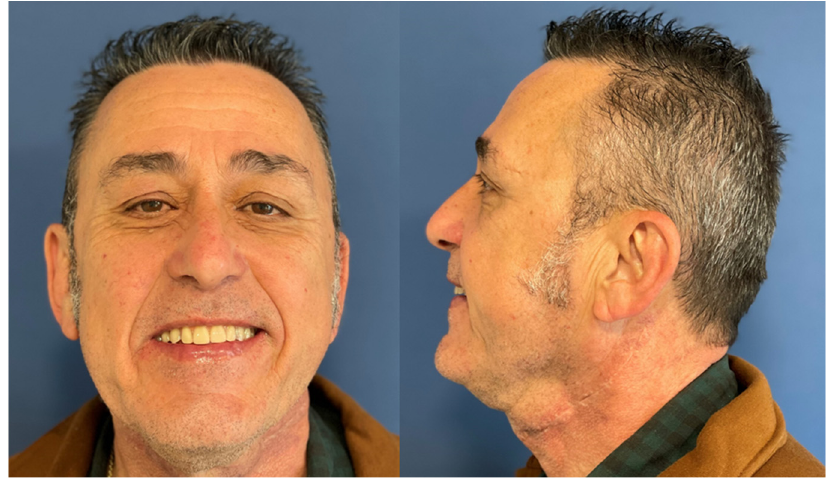
Figure 10. Panoramic radiograph after prosthetic rehabilitation with an implant-fixed prosthesis.